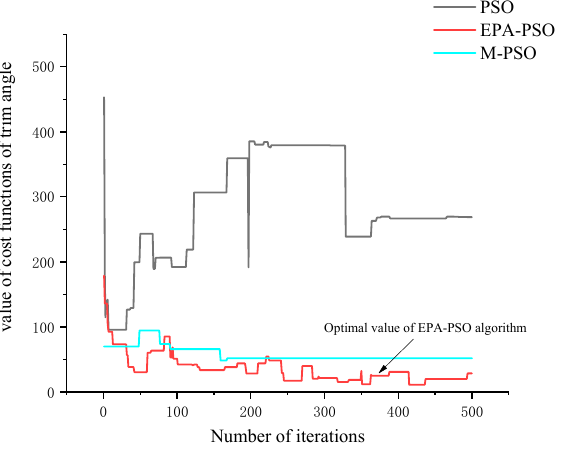
Figure 20. Numerical comparison of cost functions of trim angle after 200 iterations.